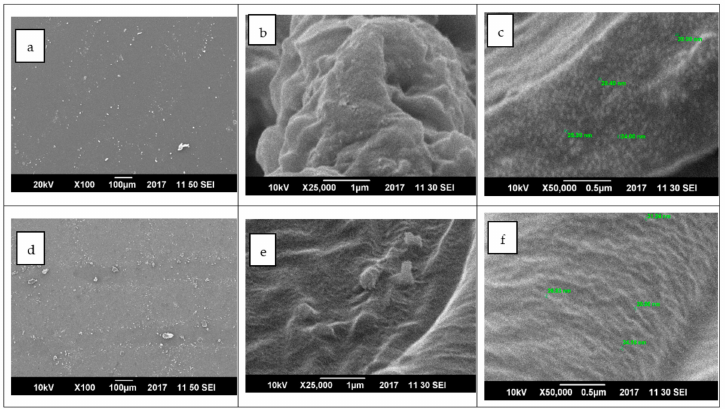
Figure 4. Scanning electron microscopy images of ( a – c ) NP3 at 100 µ m, 1 µ m & 0.5 µ m ( d – f ) CP3 at at 100 µ m, 1 µ m & 0.5 µ